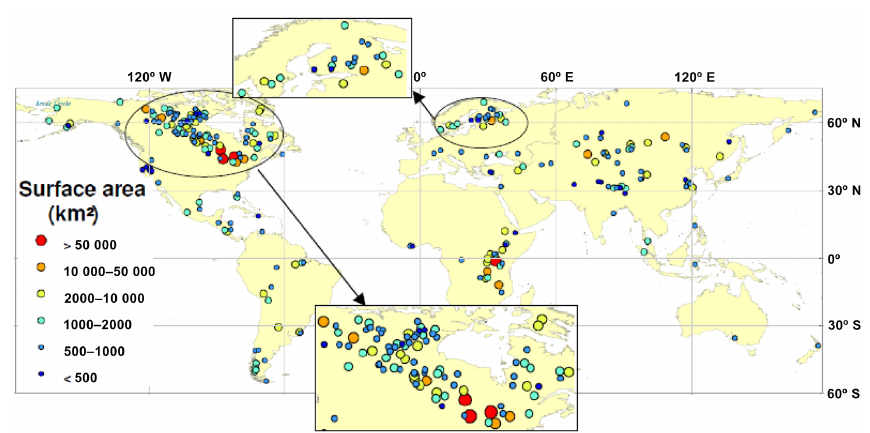
Figure 3. Location of 246 observed lakes colour coded by surface area (obtained using polygon area in Global Lakes and Wetlands Database (GLWD) showing zoomed inset of North America and northern Europe.